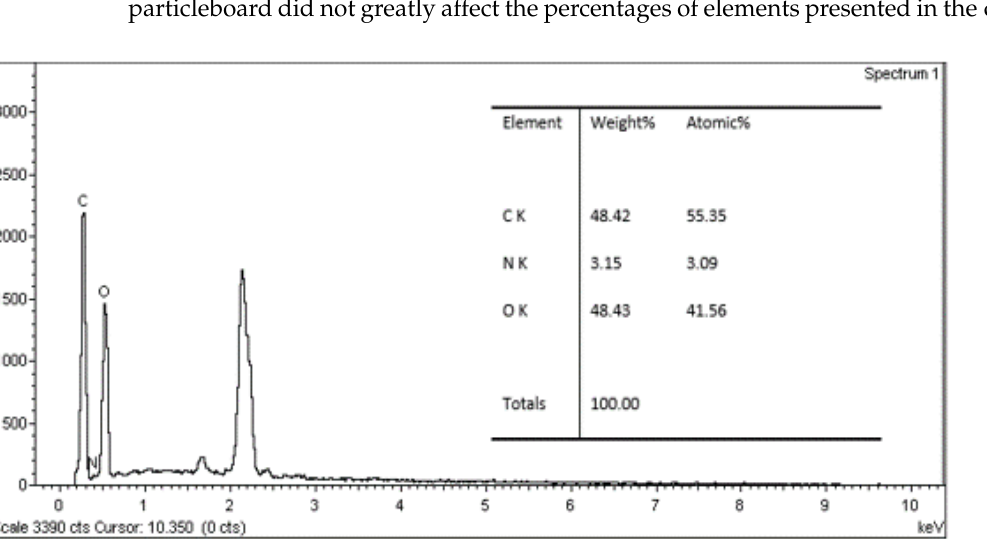
Figure 11. Energy dispersive X-ray spectrum for Rhizophora spp. particleboard bonded with 6% binders. Figure 12. Energy dispersive X-ray spectrum for Rhizophora spp. particleboard bonded with 12% binders. 3.5. Evaluation of the XRF Analysis The XRF method is the best way to identify major and trace elements within the nat- ural composition of the particleboard. The XRF analysis of major elements is recorded in